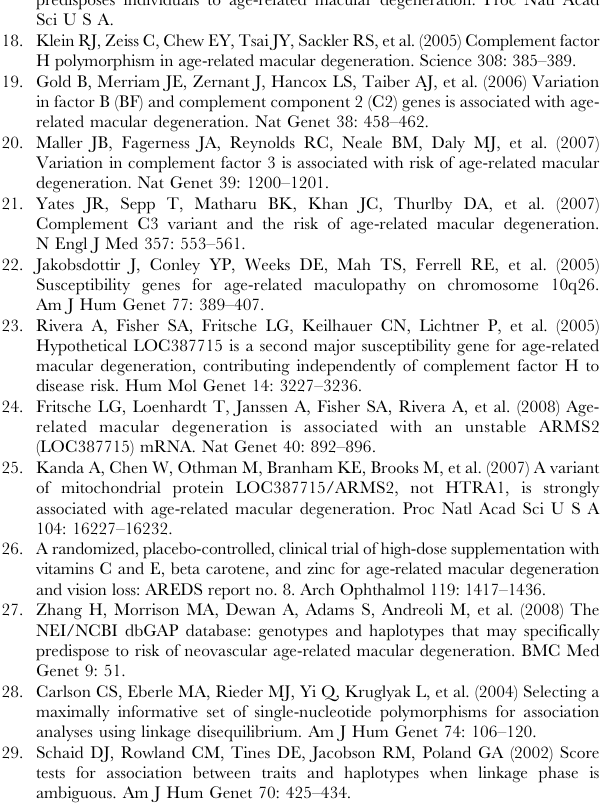
Table S4 Genotype distribution results for 6 SNPs with significant log-additive p-values in Mayo samples compared to genotype distribution results for the same SNPs genotyped in AREDS samples (replication